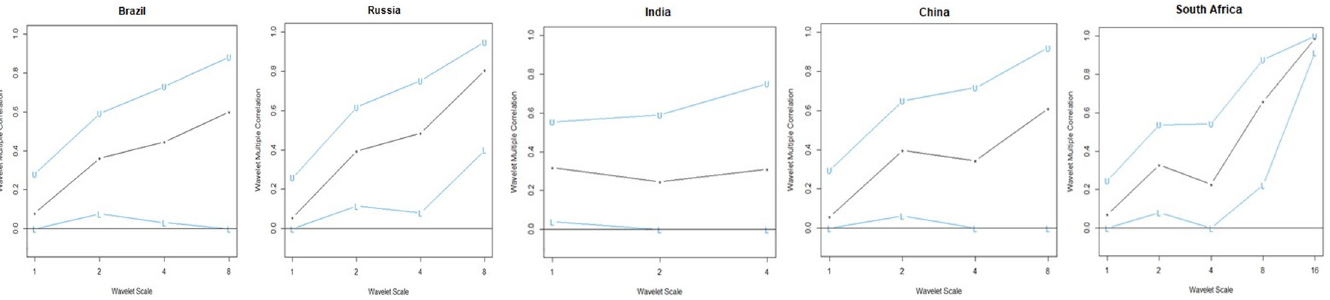
Fig 7. Wavelet multiple correlations among FSI, GDP and GEPU in BRlCS. U-upper limits, L- lower (at 95% confidence interval).